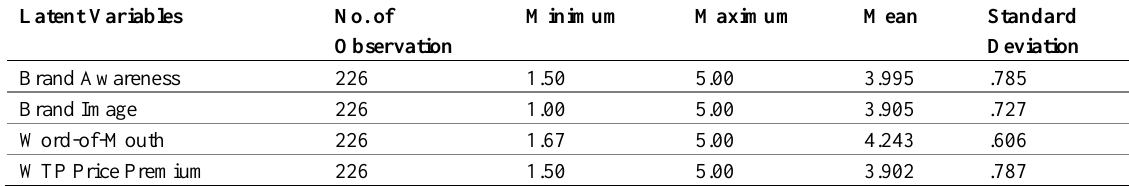
Table 1: Results of Descriptive Statistics